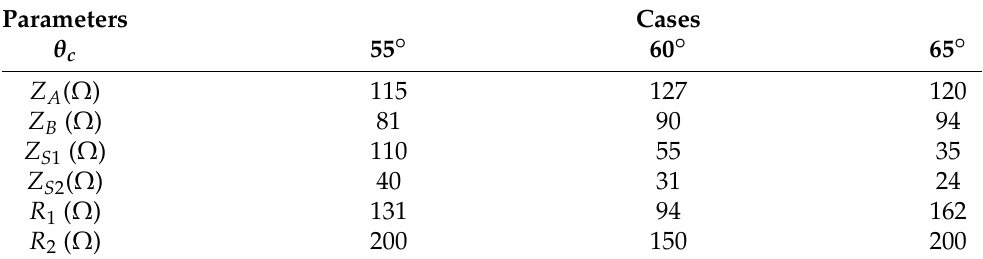
Figure 7. Relation between isolation resistor values. Table 1. Design Parameters of Wideband